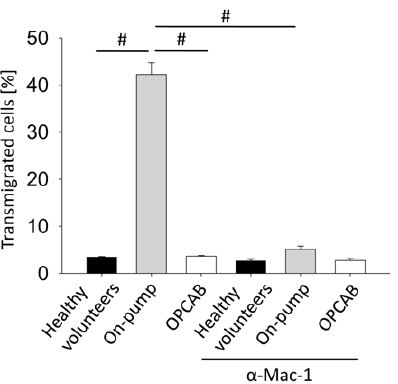
Figure 4. CPB affects intracellular signaling. The phosphorylation of PLC c 2, Akt, and p38 MAPK was investigated by western blot. Neutrophils derived from patients undergoing cardiac surgery with CPB (ON) or without CPB (OFF) obtained after induction of anesthesia, after administration of protamine, and 24 hours after the end of the surgery were left unstimulated or stimulated by rolling on E-selectin–coated wells for 10 minutes. Lysates were prepared and immunoblotted with antibodies against phosphorylated PLC c 2 (phospho PLC c 2 (Tyr1217)), total PLC c 2, phosphorylated Akt (phospho Akt (S473)), total Akt, phosphorylated p38 MAPK (phospho-p38), or total p38 MAPK (exemplary blot of 3 experiments).